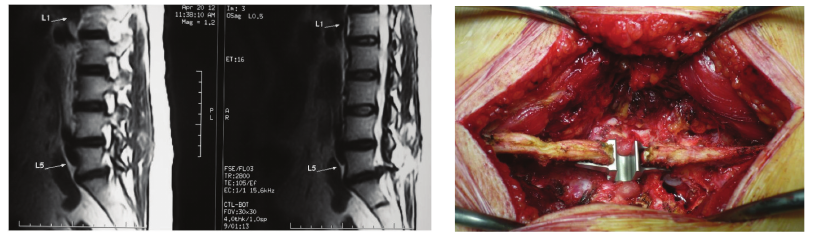
Figure 1: On the left, sagittal T2W image MRI of Lumbosacral spine showing extruded L5-S1 disc with degenerated L4-L5 disc. On the right,